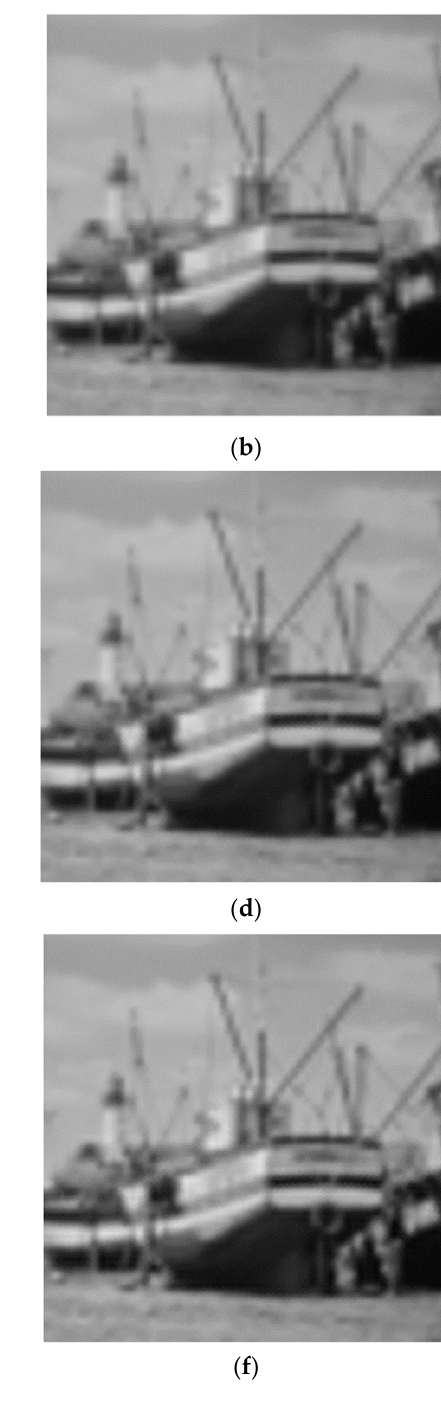
Figure 13. The interpolating image upscaling with a factor of two: ( a ) nearest neighbor; ( b ) bilinear; ( c ) bicubic; ( d ) bicubic Hermite; ( e ) Karim and Saaban [11]; ( f ) the proposed method.